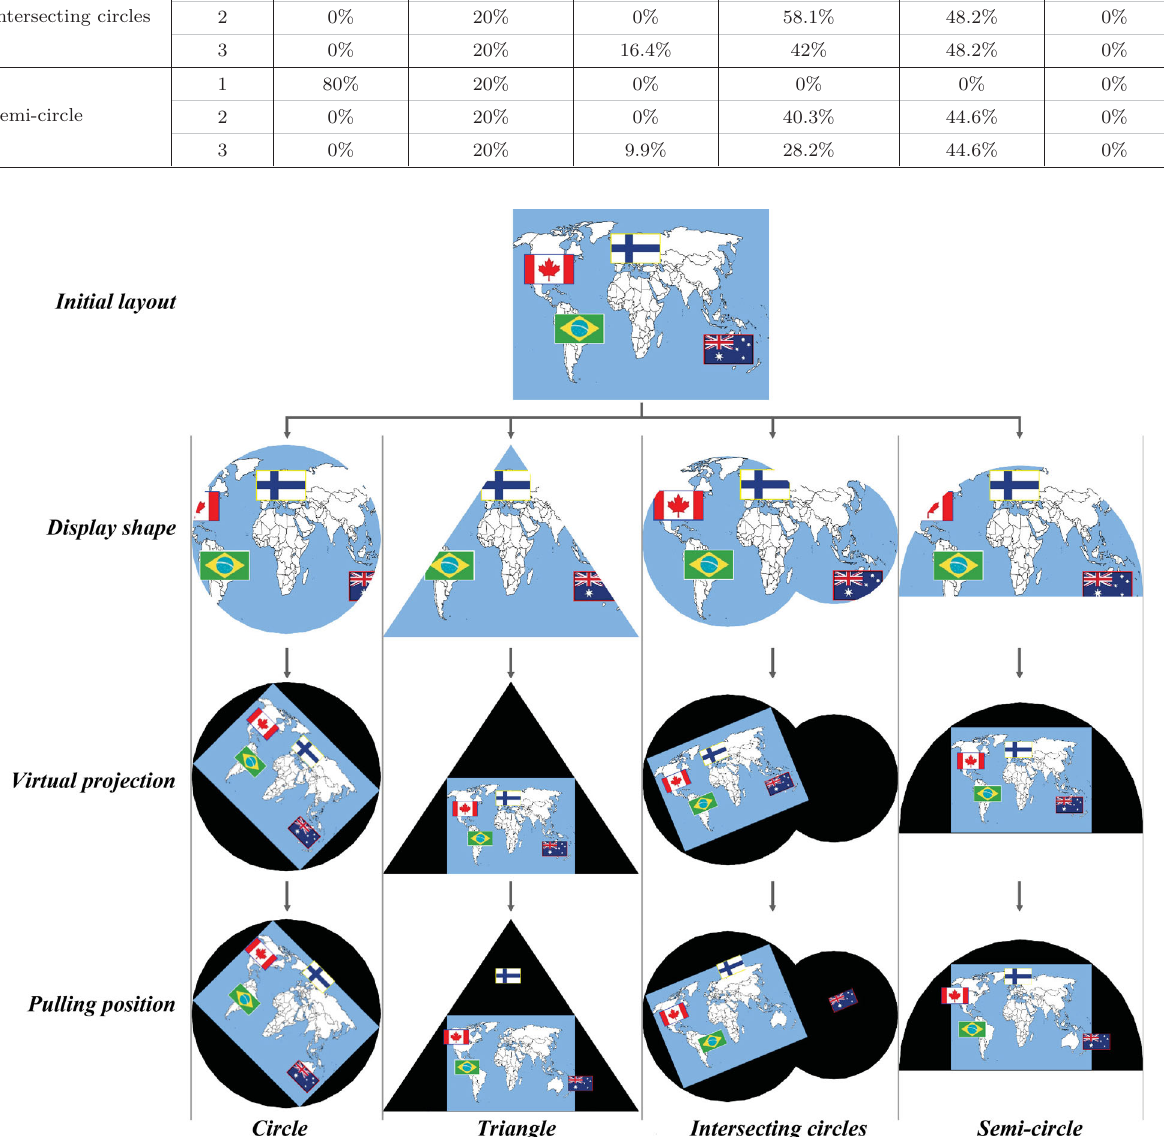
Fig. 9 Influence of the implemented technique on SynergyNet ’s Simple Map